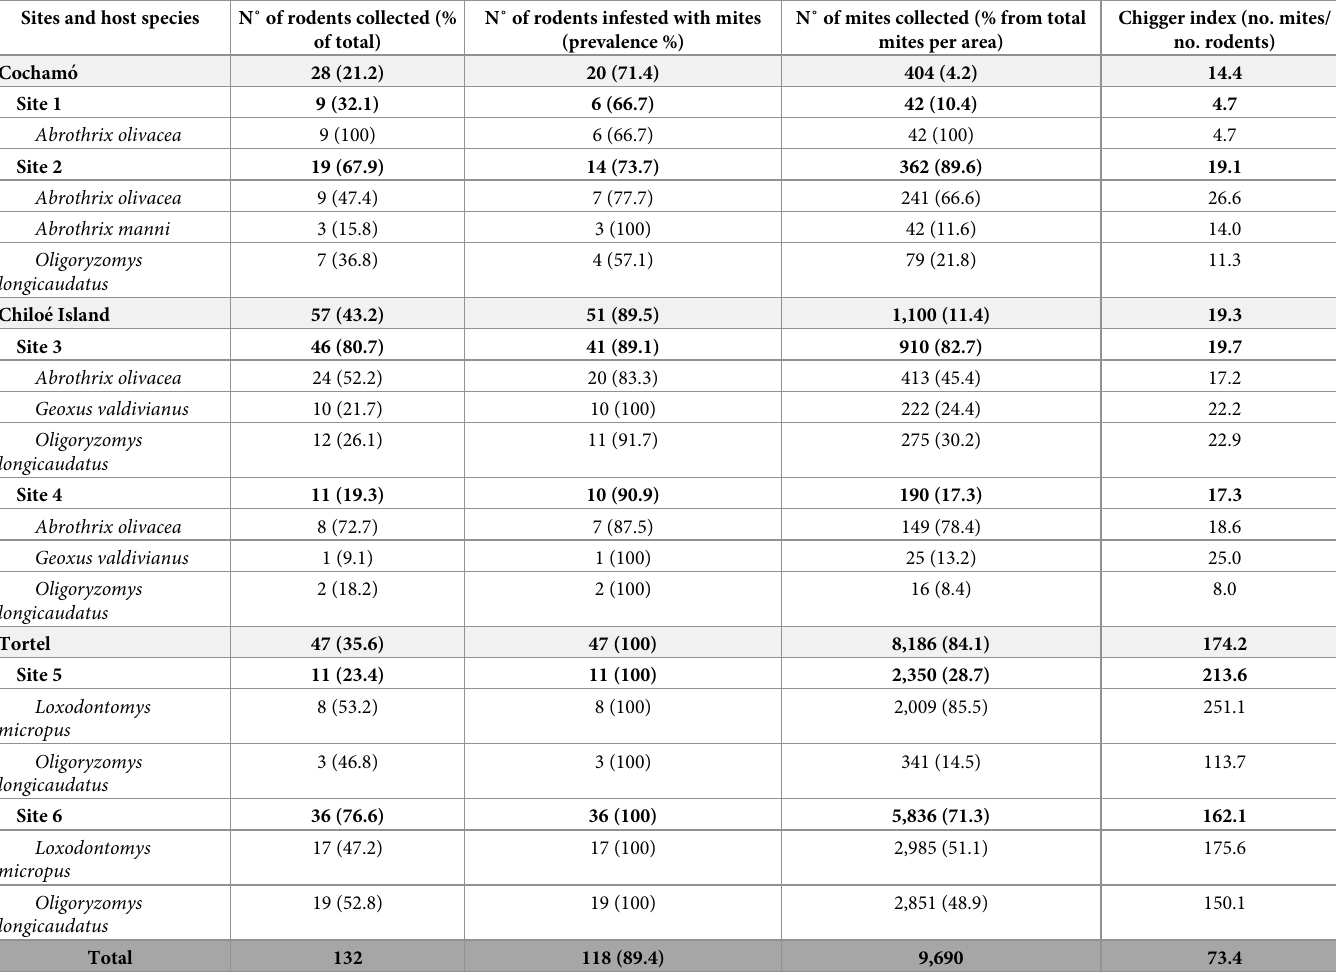
Table 1. Summary of wild rodent species and prevalence of chigger mites in each sampling